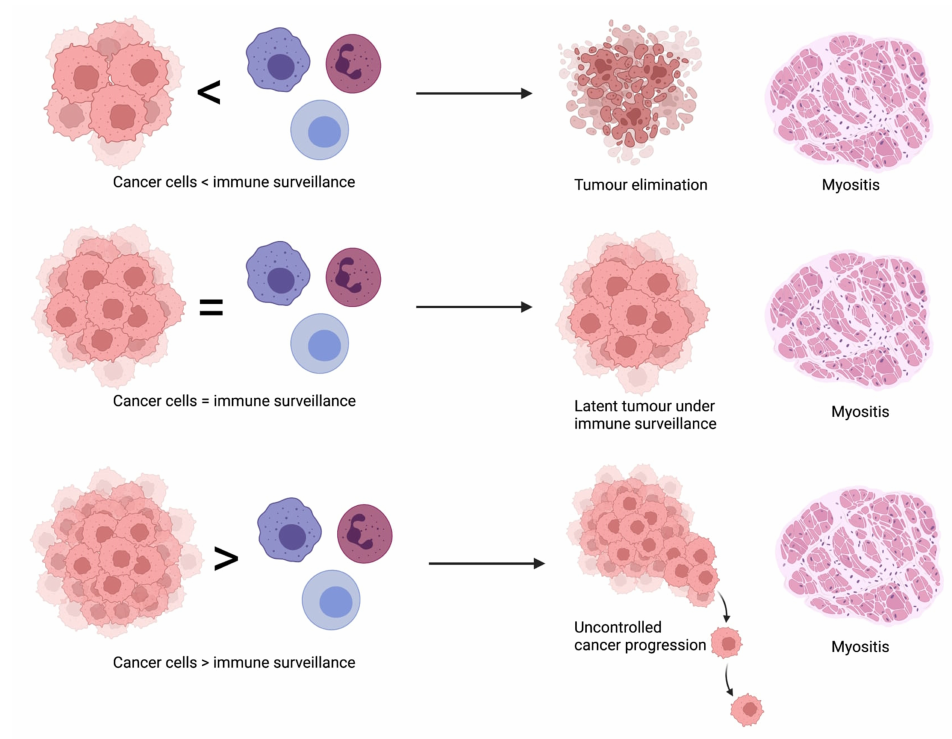
Figure 1. Courses of malignancy in myositis.